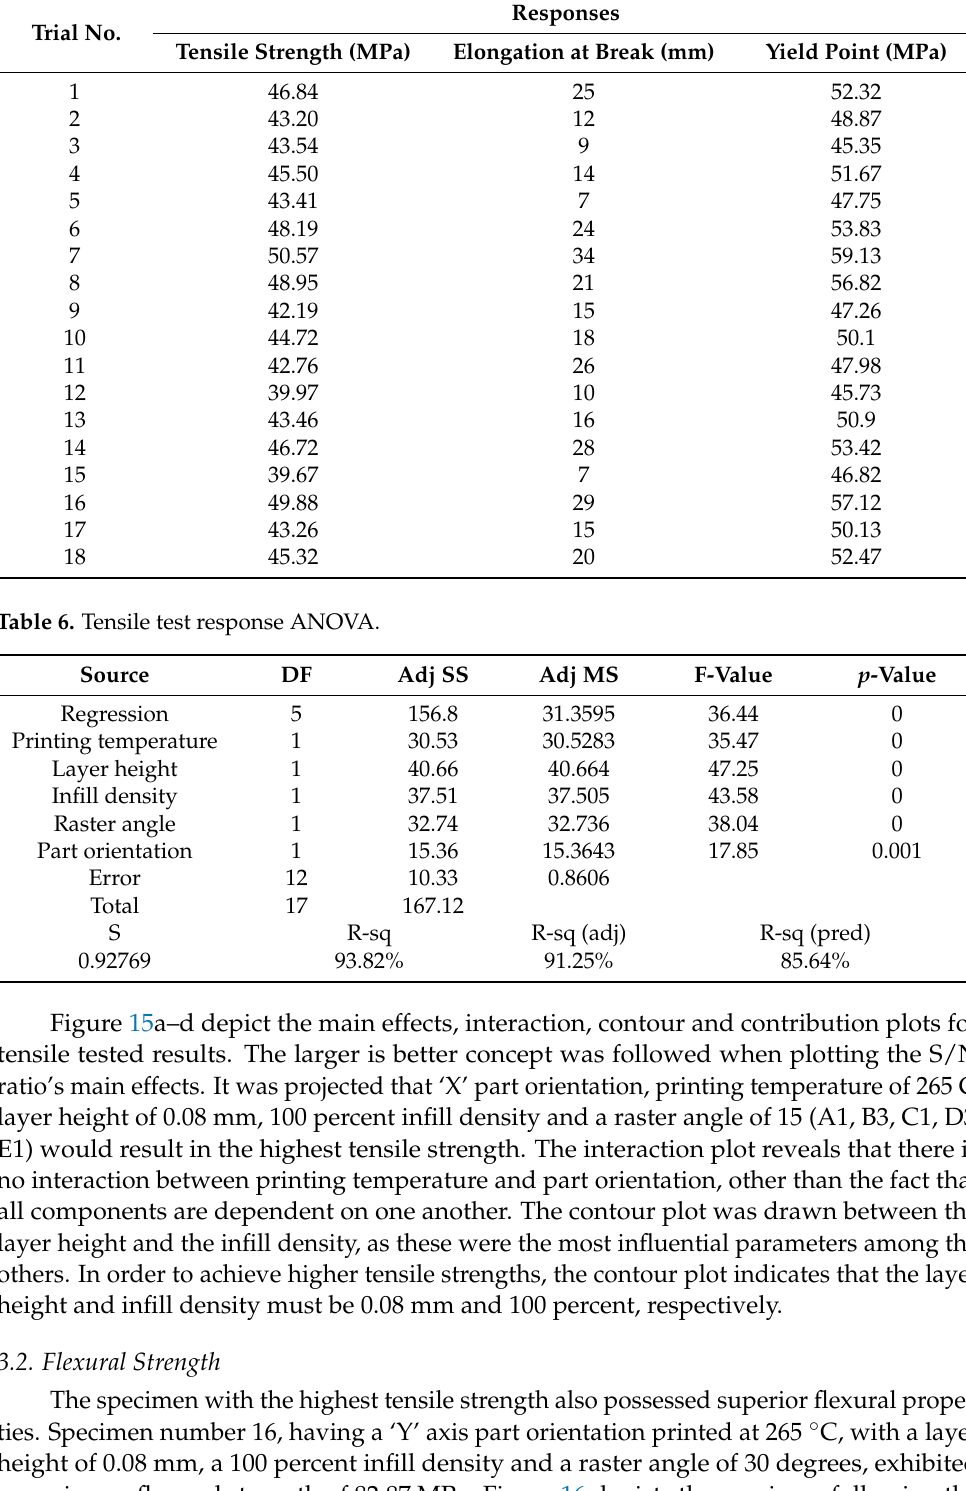
Table 5. Elongation at break and yield point values for tensile test results.